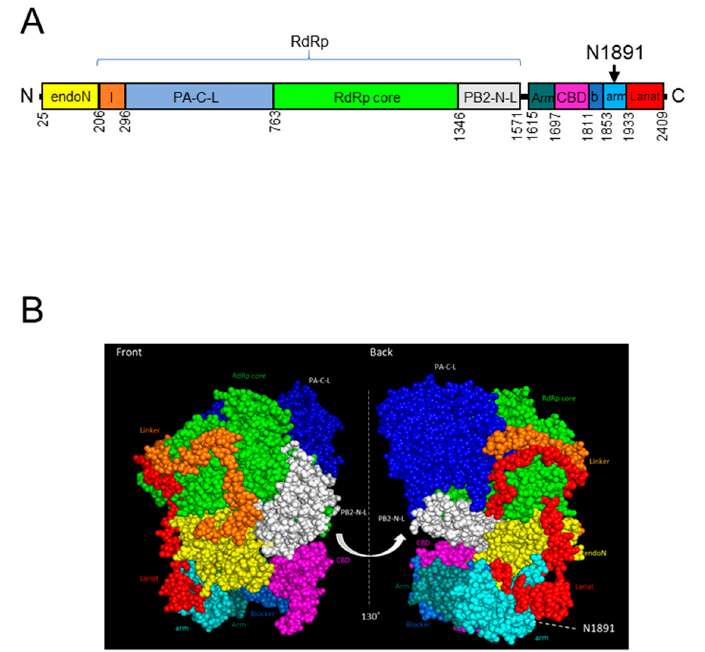
Figure 1. Overview of the severe fever with thrombocytopenia syndrome virus (SFTSV) L protein ( A ) The schema of the SFTSV L protein. The endonuclease domain (endo N, yellow), linker region (l, orange), PA-c-like domain (PA-C-L, blue), RdRp core domain (green), PB2-N-like domain (PB2- N-L,gray-white), Arm domain (deep teal), cap-binding domain (CBD, magenta), blocker motif (b,marine-blue), arm domain (cyan), and lariat domain (lariat, red) are shown. The position of N1891 is pointed at by the black arrow [14–16]. ( B ) Estimated sphere diagrams of the SFTSV L protein with patched amino acid sequences based on the reported structure model [16] are shown from two angles. Each domain is shown in the same color as A. The sidechain of position N1891 is shown in red dots, and the position of N1891 is indicated by a white dotted line.